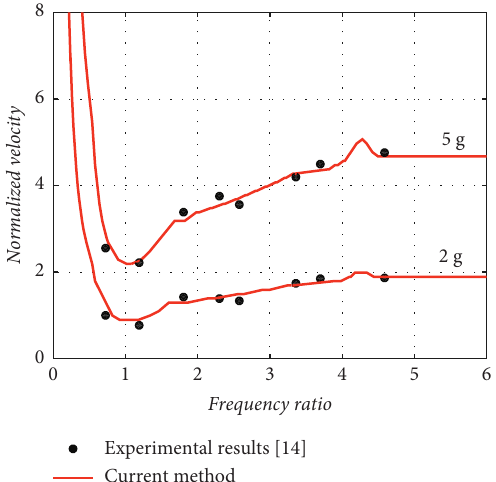
Figure 4: DDBCs of the packaging system with linear stiffness from a simulation and experiment at 2g and